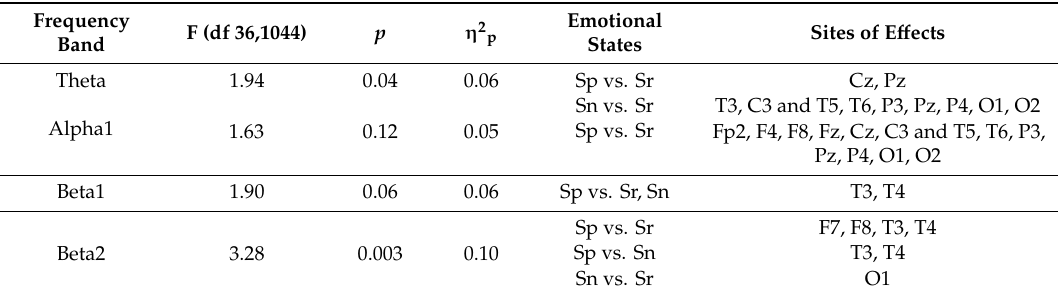
Table 2. ANOVA results indicated regional e ff ects of EEG di ff erences between emotional states. Frequency F (df 36,1044) p η 2 p Band